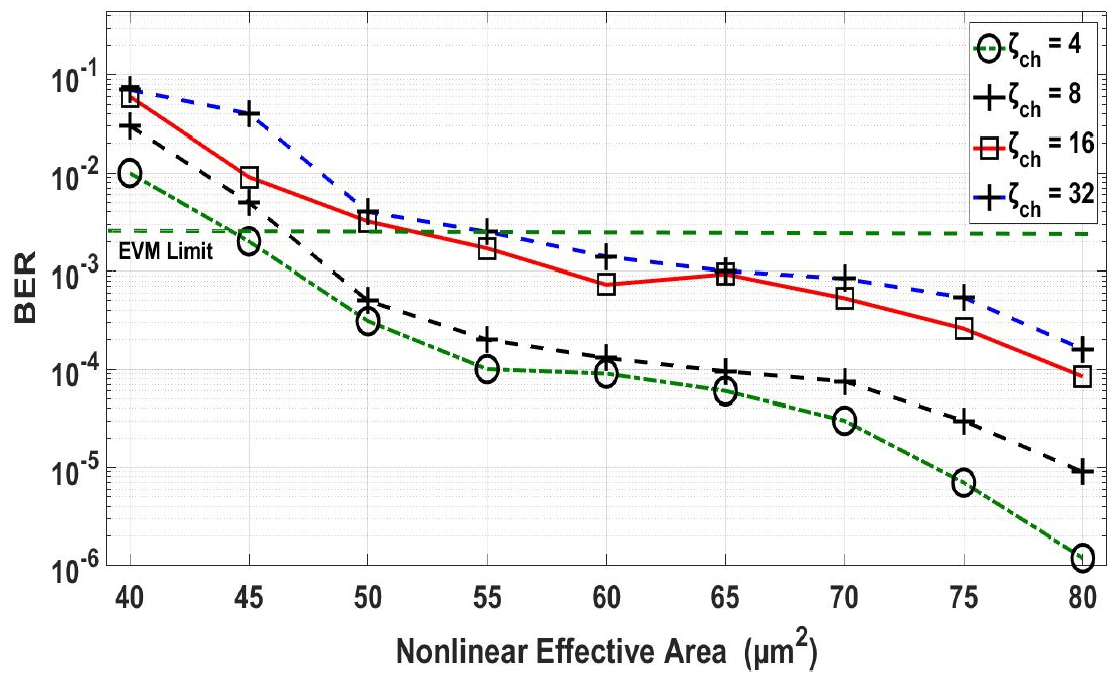
Figure 9. BER versus nonlinear effective area for 4, 8, 16 and 32 channels (50 GHz channel